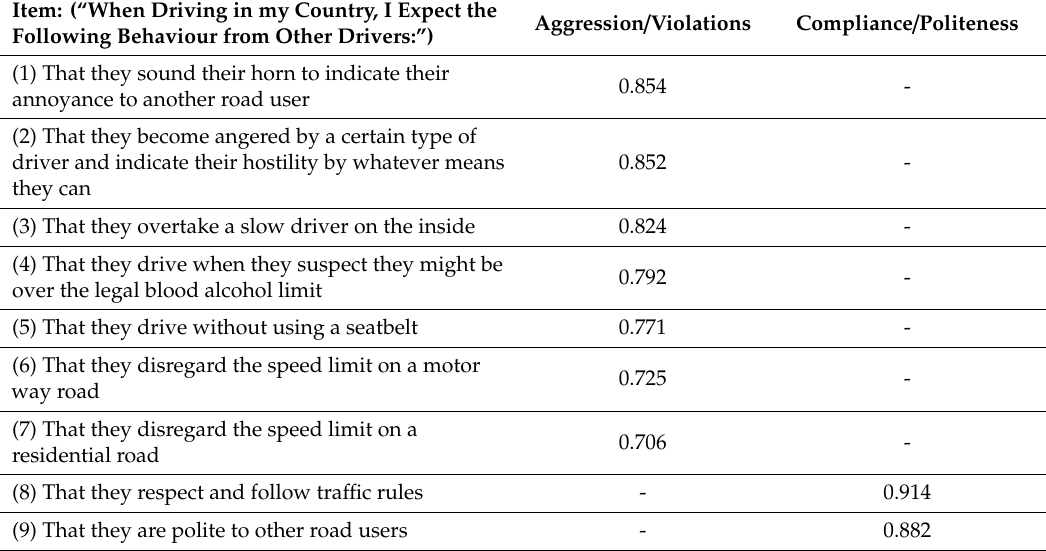
Table 7. Factor analysis results: national road safety culture scales.